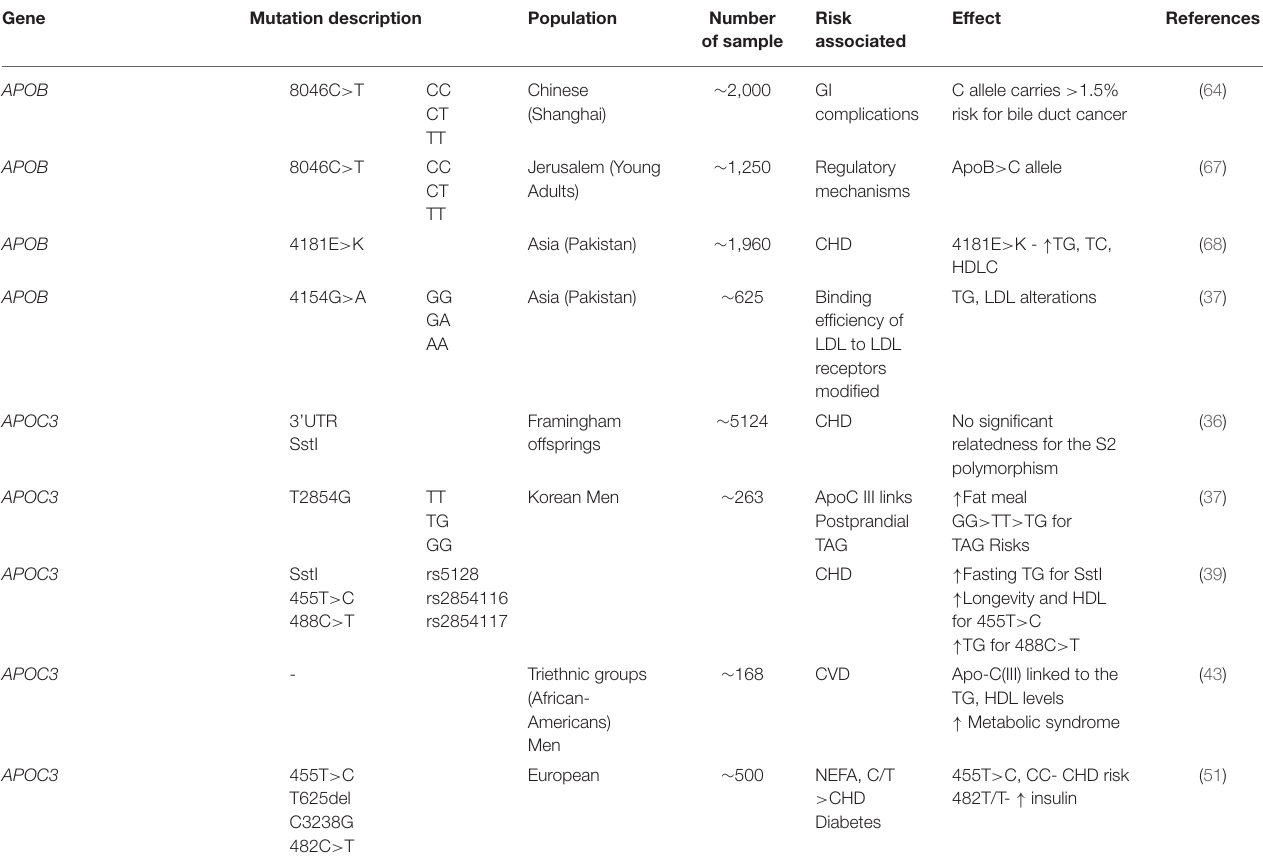
Apolipoprotein E Apolipoprotein E or APOE is a 34 kDa (kilo Dalton) protein comprising 299 amino acid residues that transport lipid molecules (69). The protein is encoded by the APOE gene (OMIM: 107741) located in chromosome 19, having 4 exons (70). The APOE gene variants generate from the exon 3 region contributing to the rs7412 C/T and rs429358 ( APOE4 ) (71, 72) major haplotypes as shown in Figure 3 . These isoforms ε 3 have cysteine and arginine residues in 112th and 158th positions, respectively, and ε 4 has two cysteine and two arginine residues, respectively (74). It contributes to six major genotypes, such as ε 2/ ε 2, ε 3/ ε 3, and ε 4/ ε 4 that are homozygous forms and ε 2/ ε 3, ε 3/ ε 4, and ε 2/ ε 4